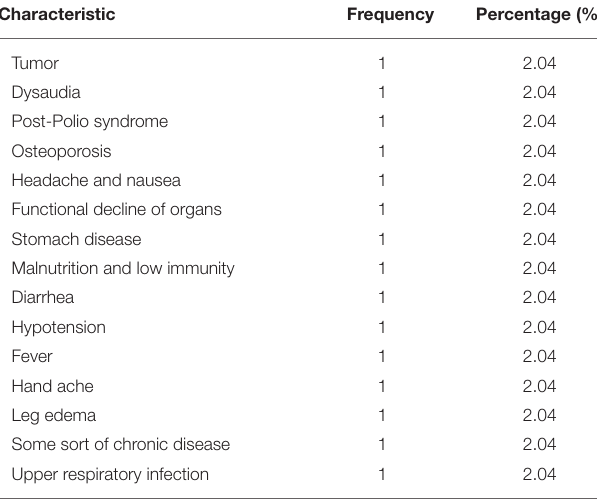
TABLE 2 | The changes in the lives of homeless people before and during the pandemic ( n =